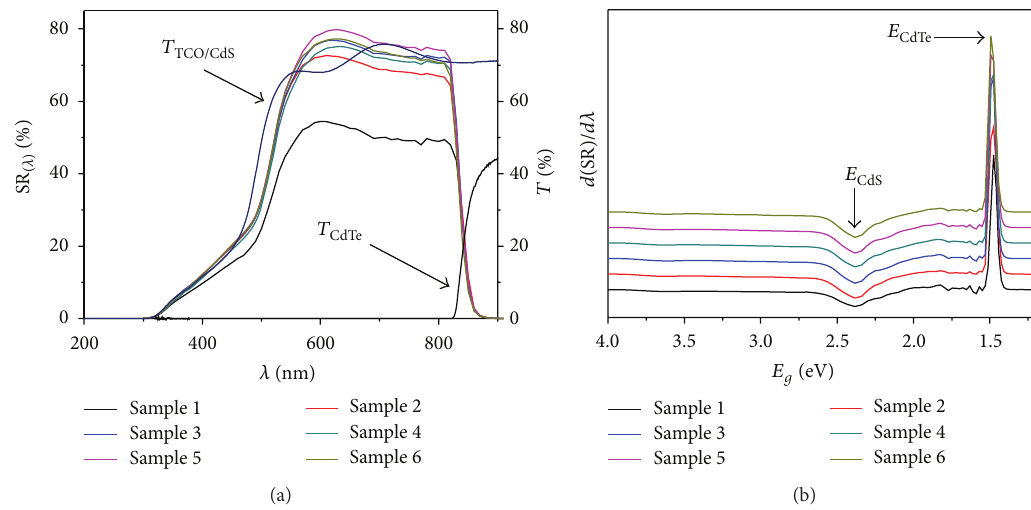
Figure 2: (a) SR of cells. For comparison, 𝑇 ITO / CdS and 𝑇 CdTe are listed in this figure, respectively. (b) Plots of 𝑑( SR )/𝑑𝐸 versus 𝐸 for cells, photon energy 𝐸 is obtained by 𝐸 = 1240/𝜆 , and 𝐸 𝑔 of CdS and CdTe is also marked in this figure.